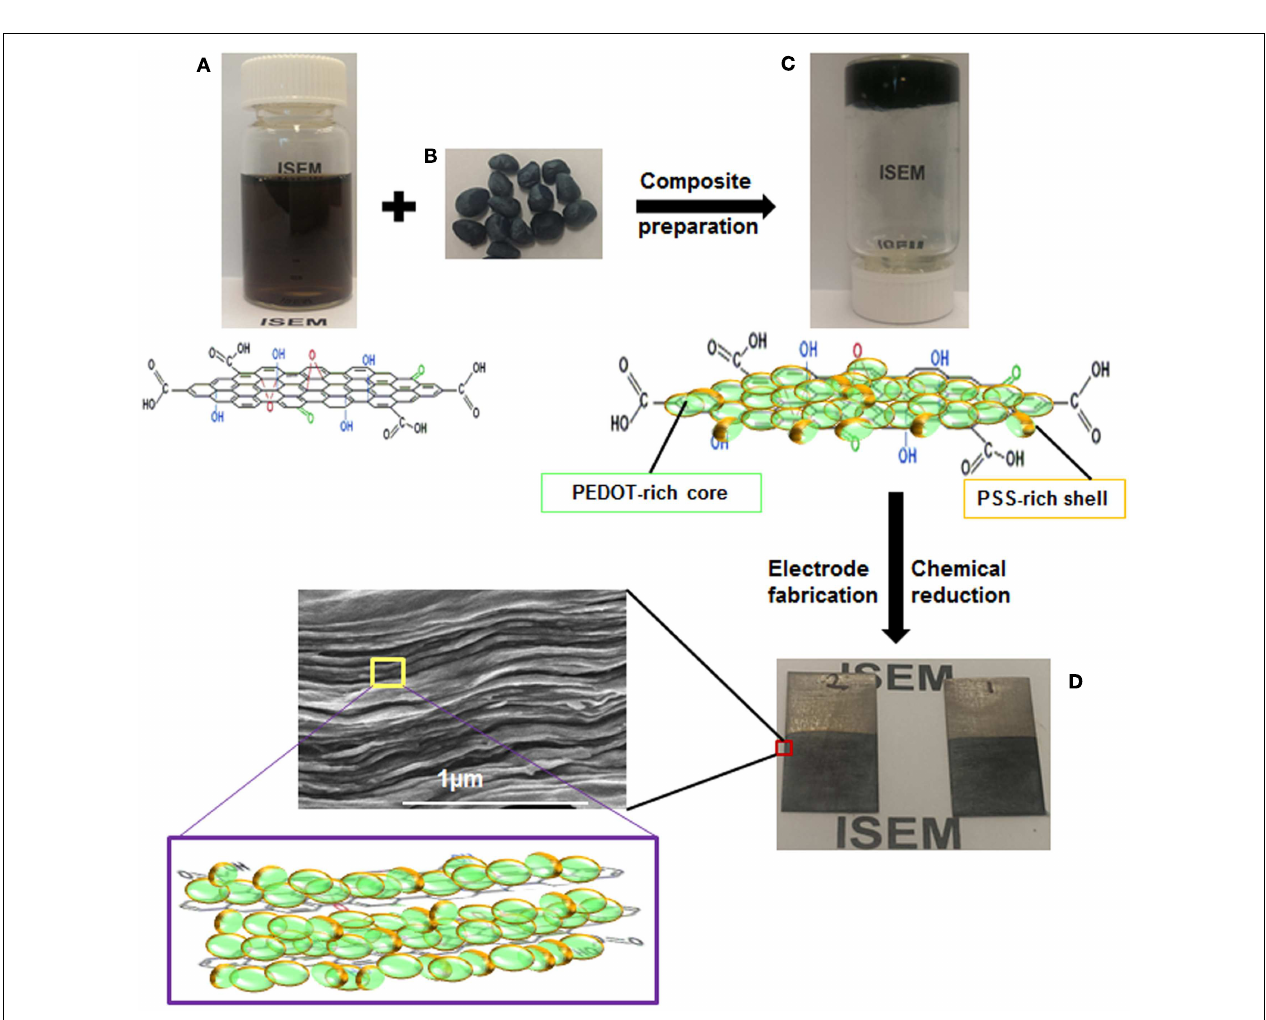
FIGURE 1 | Schematic illustration of preparation of binder-free electrodes: (A) LC GO, (B) PEDOT:PSS, (C) GO-PP composite, and (D) binder-free as-prepared electrodes .